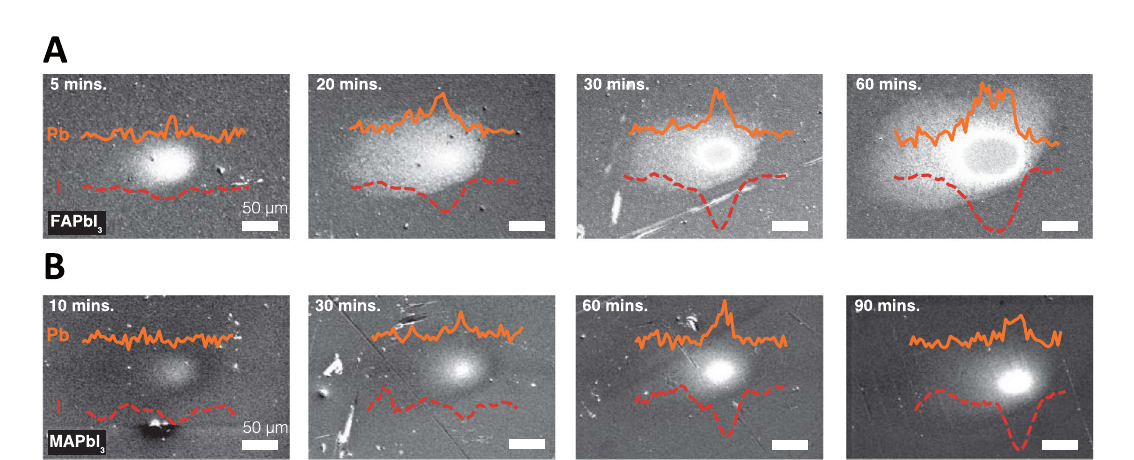
Fig. 1 | Schematic illustrationofthe experimental setup and sample structure. A IllustrationoftheSEMexperimentalplatformincorporatinganinsitulaserbeam with SEI and EDS detectors. B The measured EDS spectra of FAPbI 3 without light exposureattheprimaryelectronenergiesof30keV(blueline)and5keV(redline). The corresponding elements are annotated near each characteristic peak. Also shown are the simulated trajectories of primary electrons with energies of ( C )